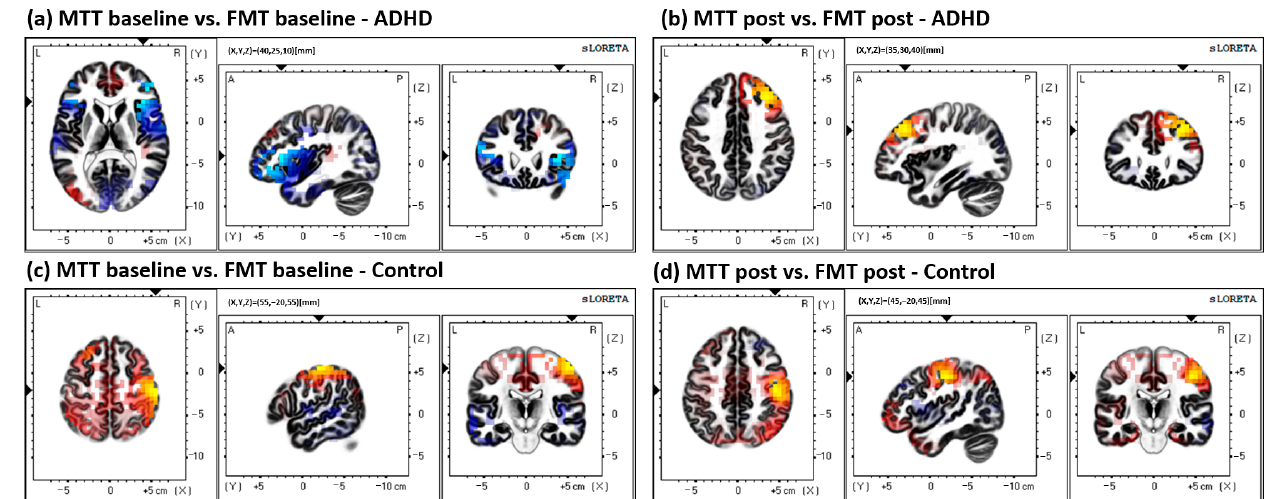
Figure 6. All between-task (MTT vs. FMT) comparisons. All results yielded were insignificant ( p > 0.05). ( a ) Comparison of baseline activity between tasks in the ADHD group (MTT < FMT), differential activity in BA 13, inferior frontal gyrus, frontal lobe. ( b ) Comparison of post-acquisition activity between tasks in the ADHD group (MTT activity > FMT activity); the greatest difference was found in BA 9, middle frontal gyrus, and the frontal lobe. ( c ) Between-task baseline activity comparisons in the control group (MTT > FMT); the greatest difference was found in BA 1, postcentral gyrus, and the parietal lobe. ( d ) Between-task post-acquisition activity comparison in the control group (MTT > FMT); the greatest activity difference was found in BA 4, precentral gyrus, frontal lobe.